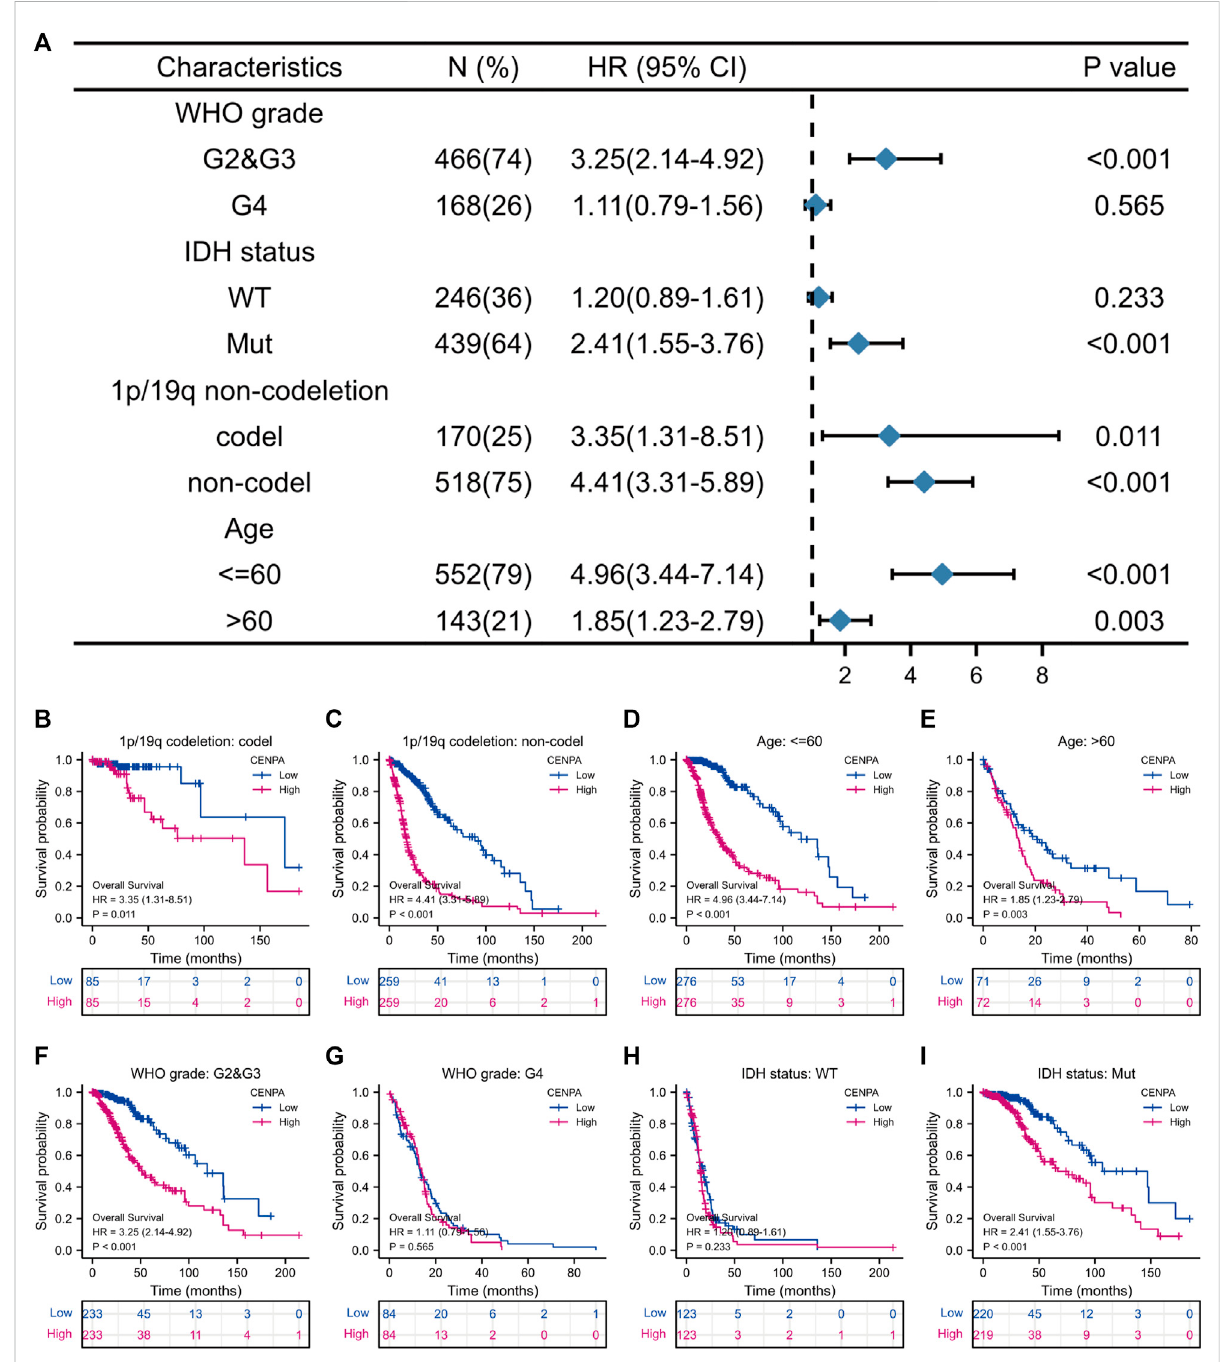
FIGURE 4 The correlation of CENP-A expression with glioma prognosis among patients with various clinicopathological characteristics. (A) Forest plots showing the subgroup analysis of overall survival. (B – I) Kaplan – Meier survival curves of each patient